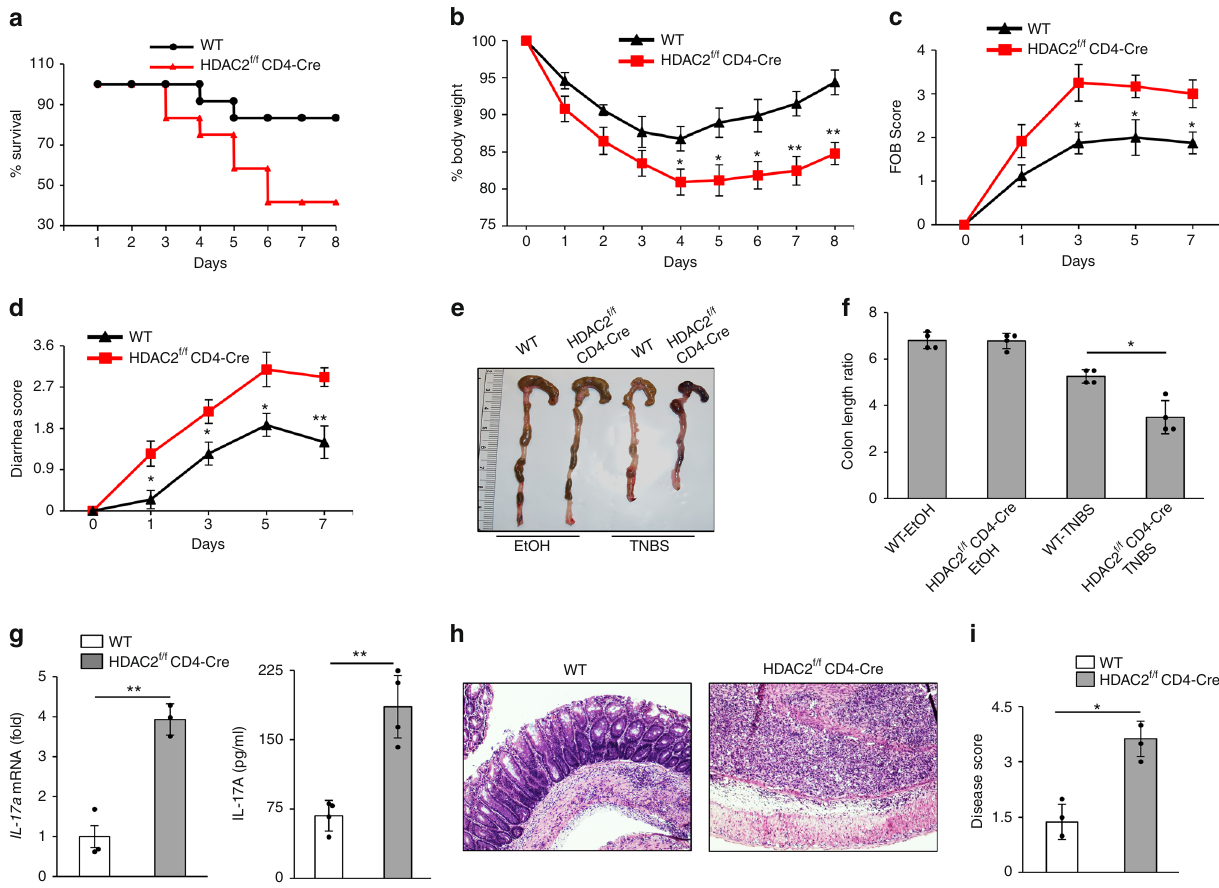
Fig. 6 HDAC2 f/f CD4-Cre mice show enhanced colitis. Data shows a survival curve (%) ( n = 12 per group), b percentage change in body weight, c FOB score, d diarrhea score, and e , f colon length of WT mice and HDAC2 f/f CD4-Cre mice ( n = 6 per group) after intrarectal administration of 2.5% TNBS. g Real-time PCR and ELISA were used to analyze IL-17A expression in WT mice and HDAC2 f/f CD4-Cre mice given TNBS. h H&E-stained colonic sections and i disease scores of those sections are shown from WT mice and HDAC2 f/f CD4-Cre mice as in a – d ( n = 4). Data are from one experiment representative of three independent experiments with similar results. * p < 0.05 and ** p < 0.01 (two-tail t test) error bars are